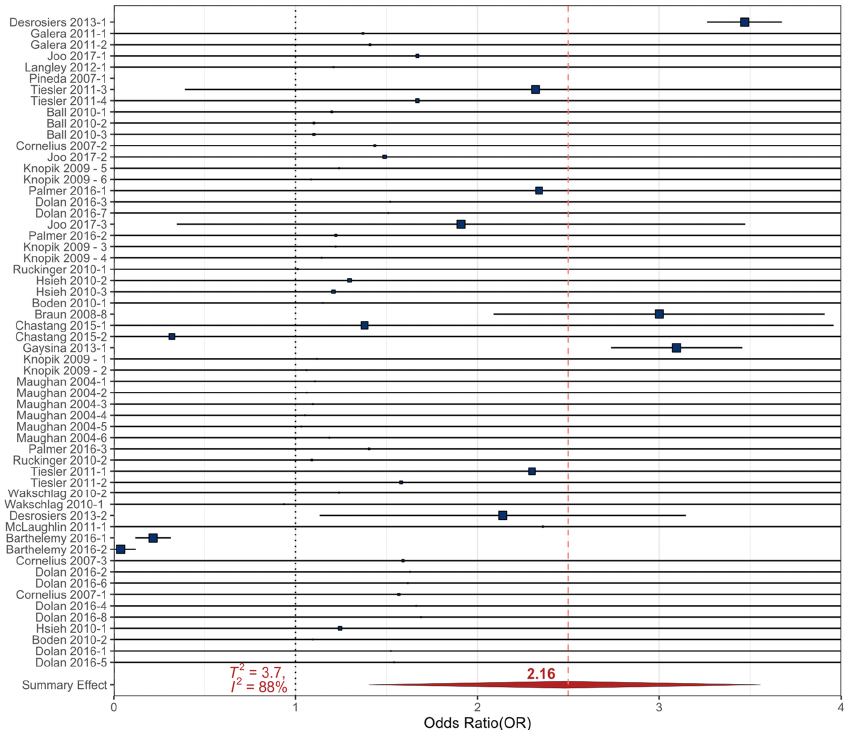
Figure 2. Forest plot showing the random effects meta-analysis for prenatal exposure to cigarette smoke and all childhood externalizing behavioral health outcomes. The squares represent the mean OR from each sampling event (Table S2), horizontal bars are the upper and lower 90% CI, the size variation of the boxes represents the weight each dataset had in the meta-analysis with a larger size indicating larger weights. The diamond and dashed line represent the summary effect OR from the meta-analysis. The ‘line of no effect’ at an OR of 1 is indicated with a dotted line.